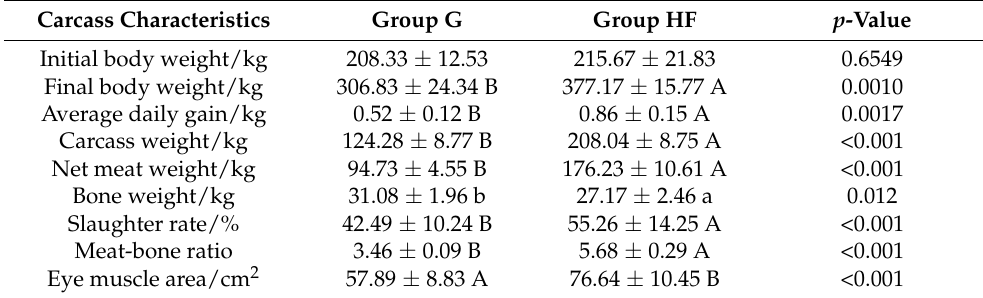
Table 2. Growth performance of yaks in different feeding systems.